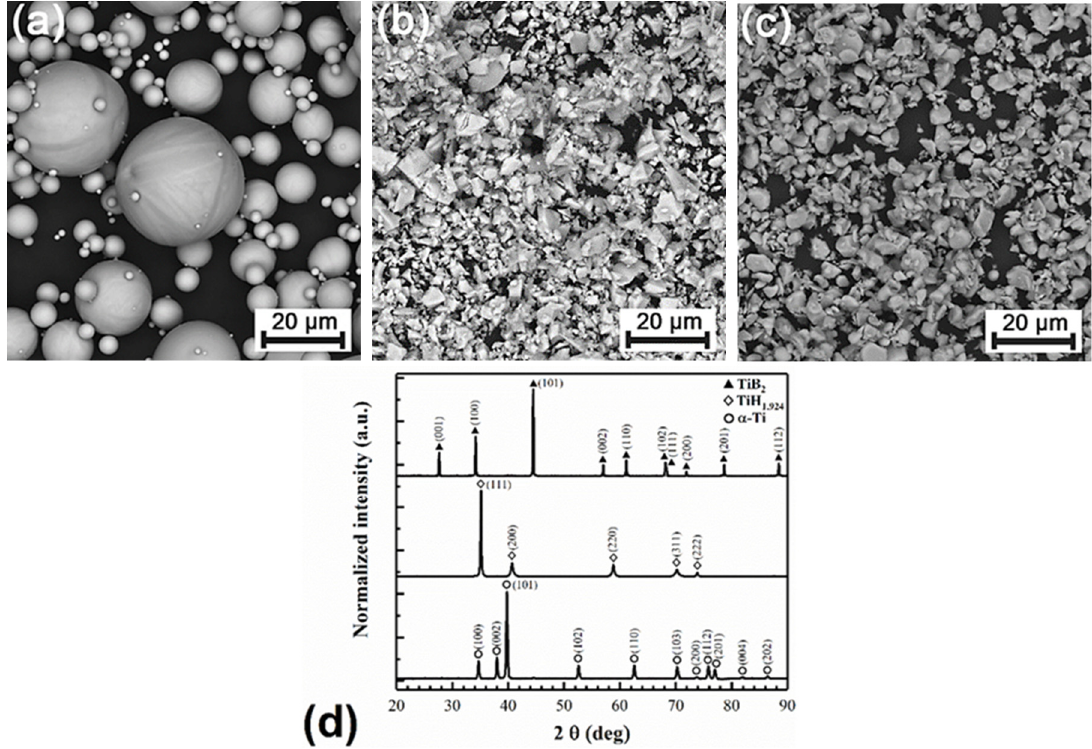
Figure 1. SEM micrographs of raw powders ( a ) CP- Ti Grade 1, ( b ) TiH 2 grade VM, ( c ) TiB 2 reinforce- ment particles, and ( d ) the XRD spectra as receive